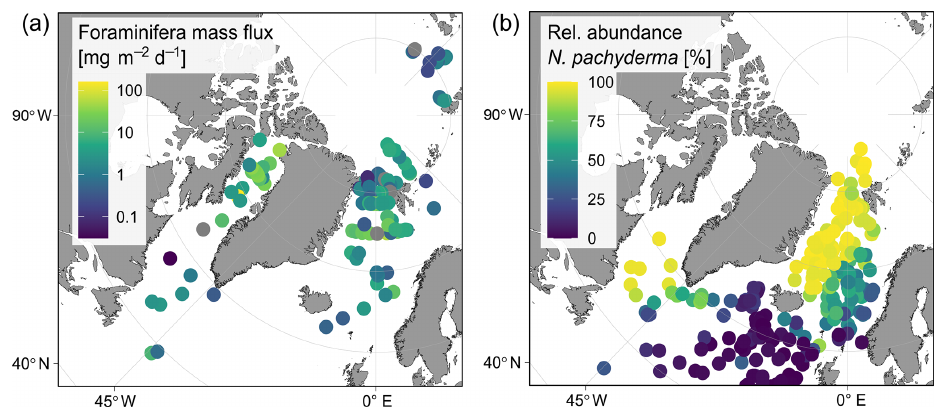
Figure 11. Regional overview of (a) foraminifera CaCO 3 mass flux of planktonic foraminifera N. pachyderma during summer (sampling period from June to September, varies among stations as shown in Fig. 1) below the estimated productive zone. Fluxes were calculated based on shell abundances determined in plankton net samples. Shell weights are either from direct measurements or based on average weights from the region of sampling. Consider that values are plotted on a logarithmic scale to visualize the huge regional variability. Panel (b) shows the relative abundance of the species N. pachyderma found in sediment cores (data from ForCenS dataset, Siccha and Kucera, 2017).